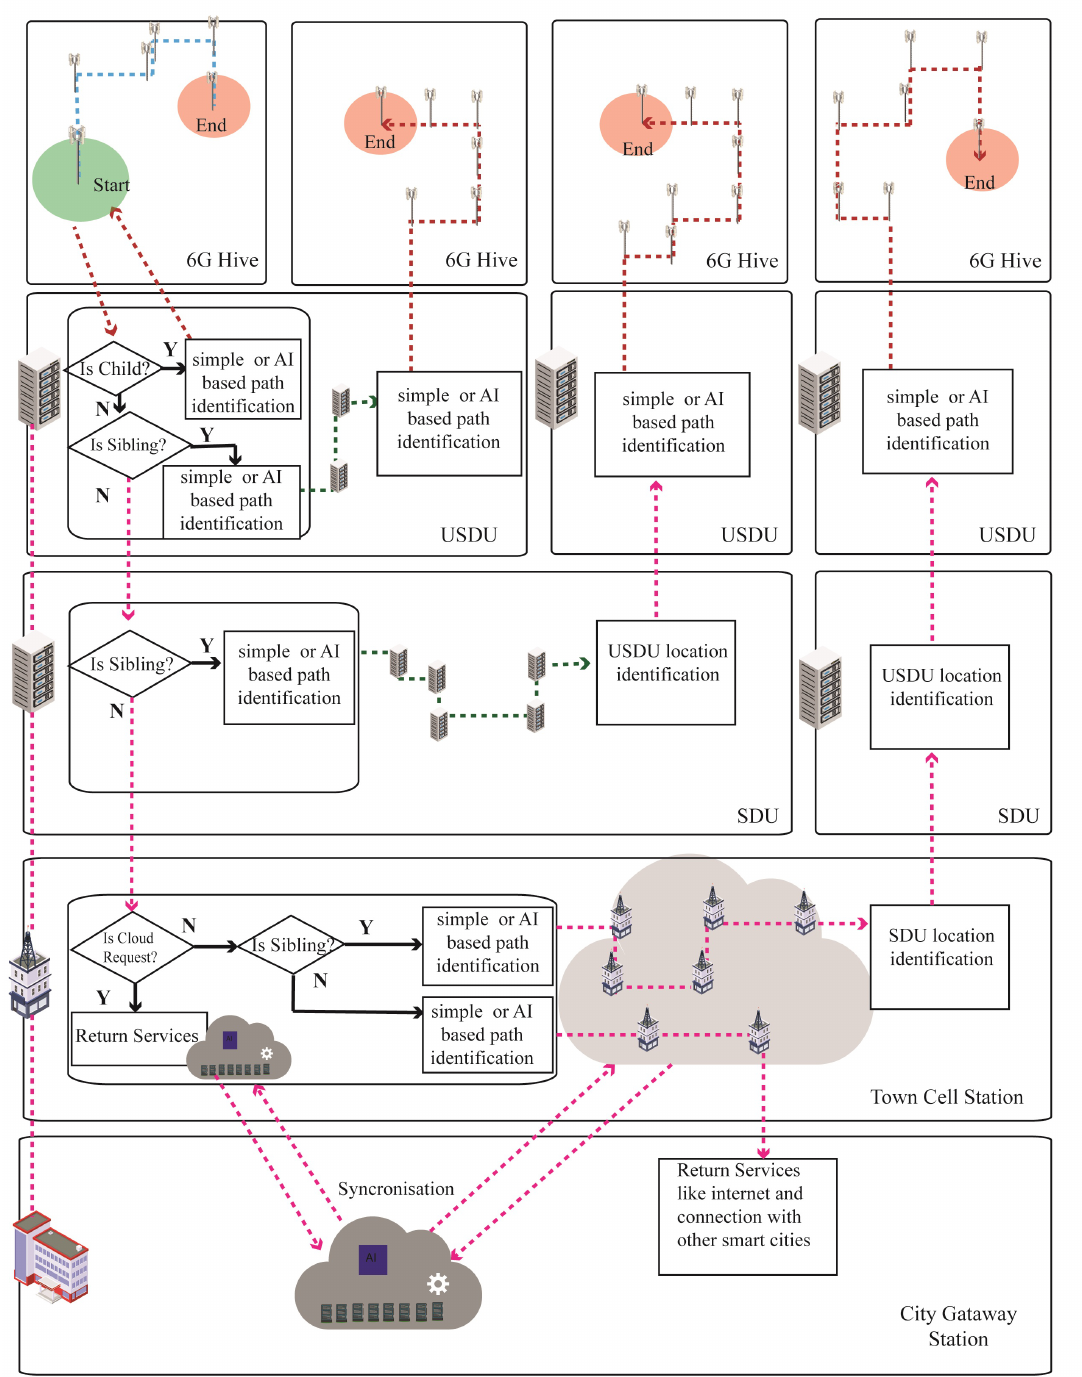
Figure 10. Communication process of 6G